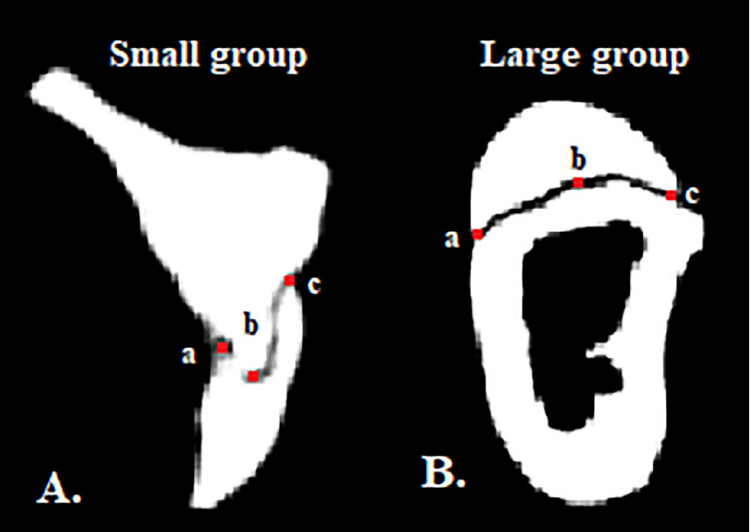
Fig 5. Cross-sectional slices of CBCT scans at the centre of the models with the fitted grafts. Representative slices depicting a small graft (A) and a large graft (B) fitted on the recipient defect sites of the alveolar ridge models; (a) lingual margin, (b) middle part and (c) buccal margin of the graft.